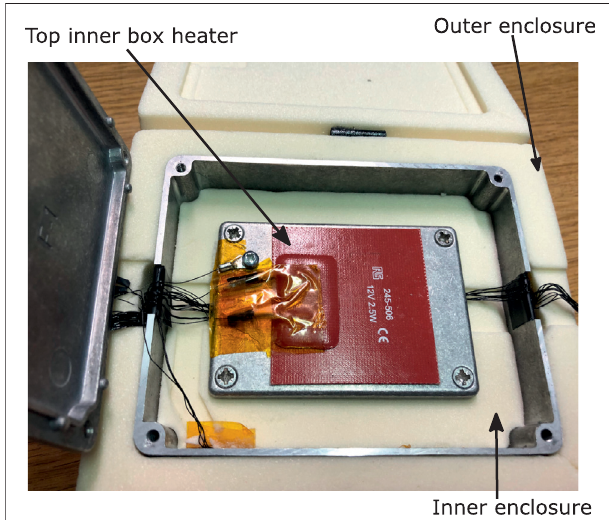
FIGURE 4 | Nested layout of the thermal enclosure used in the microelectromechanical systems gravimeter. The outer and inner foam enclosures have dimensions of 140 mm × 110 mm and 110 mm × 85 mm, respectively. The outer and inner metal boxes have dimensions of 114 mm × 87 mm and 80 mm × 55 mm, respectively.